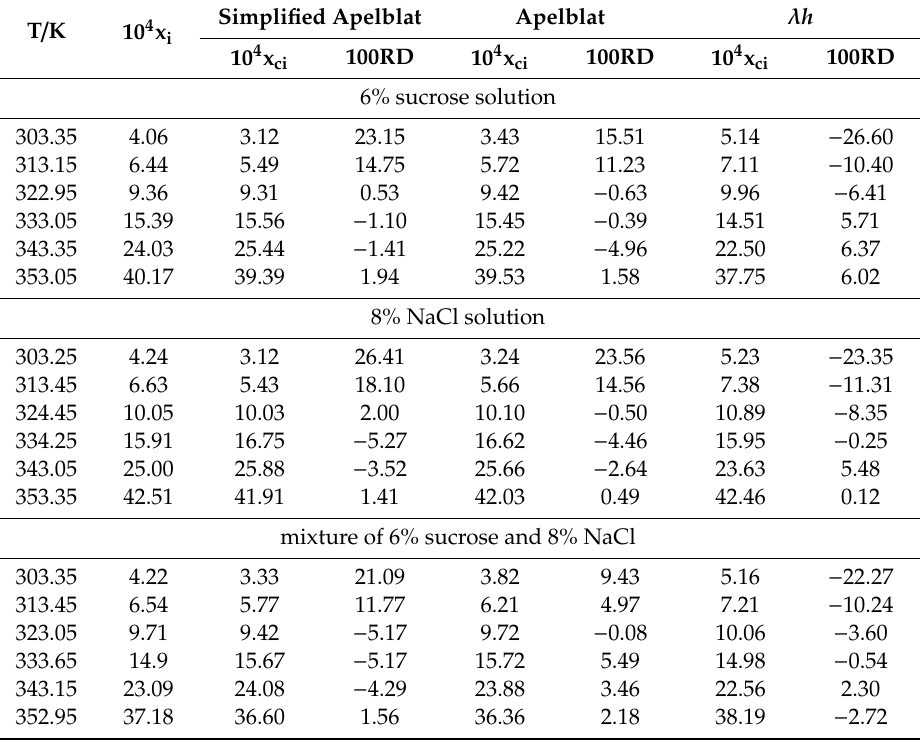
Table 2. Mole fraction solubilities of β -Cyclodextrin in the sucrose, NaCl, and mixed solutions.